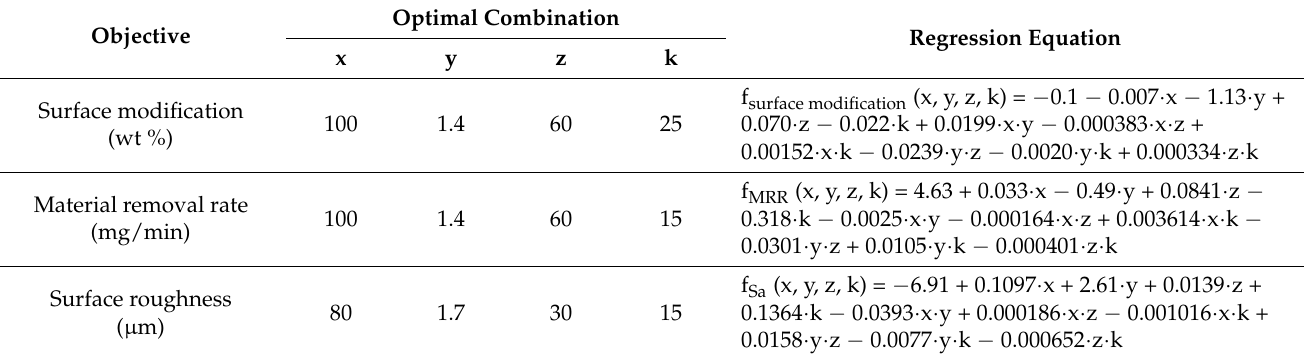
Table 4. Optimal parameter combinations for each individual objective.